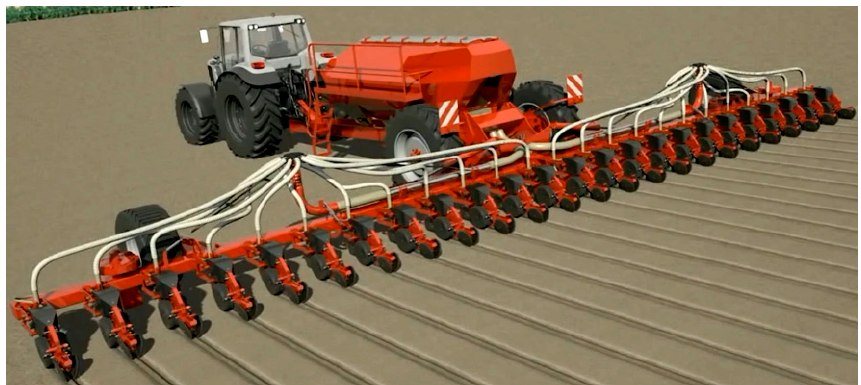
Figure 1. Tractor-planter combination in planting operation.